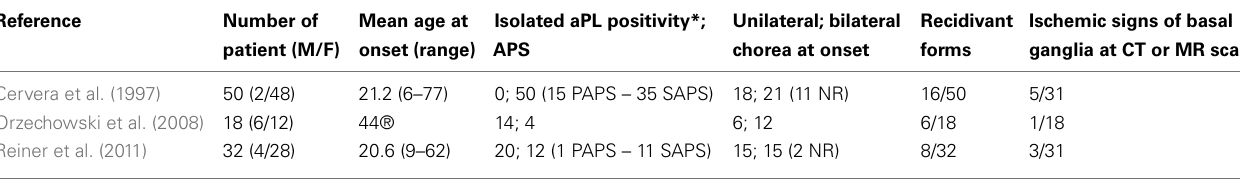
Table 1 | Clinical, diagnostic, and radiologic data from studies about aPL-related